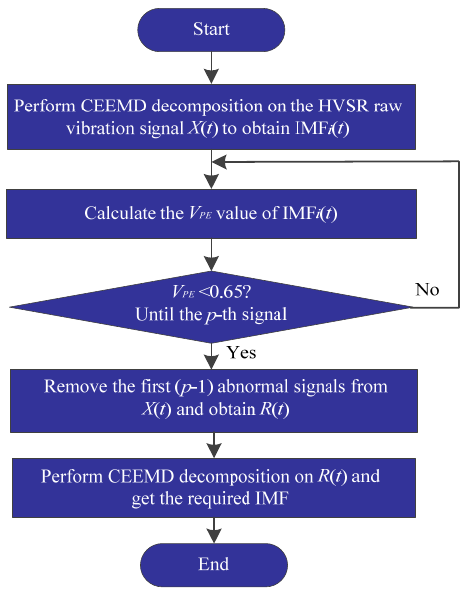
Figure 1. MCPCEEMD